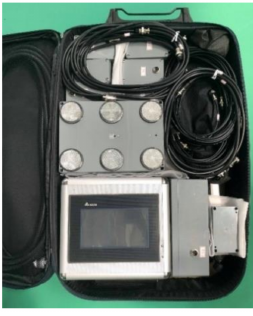
Figure 6. The packed